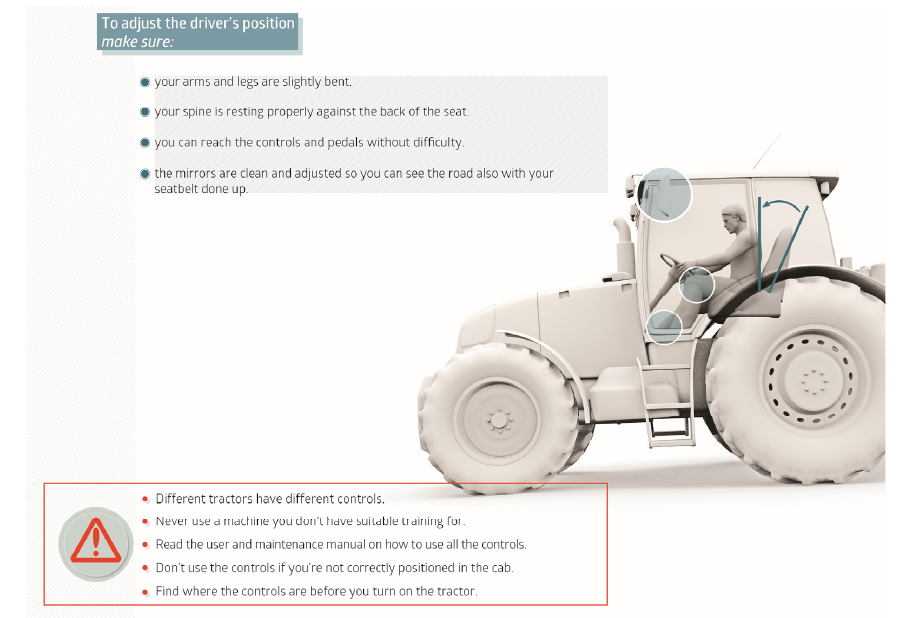
Figure 6. Intermediate draft of the section on the driving position.